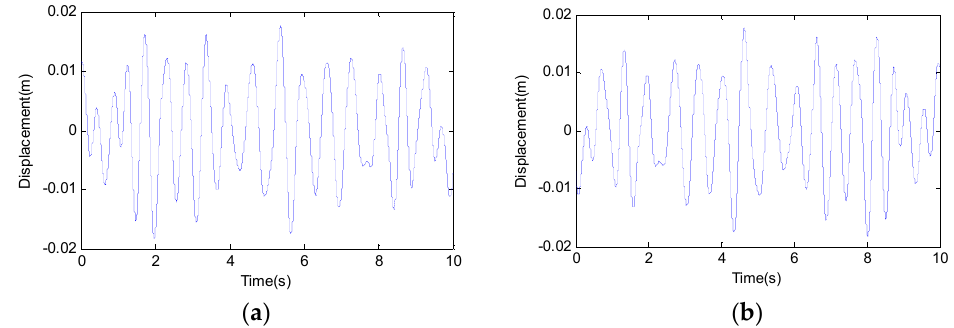
Figure 25. The seat excitation input of control simulation. ( a ) vibration excitation 1 ( b ) vibration excitation 2